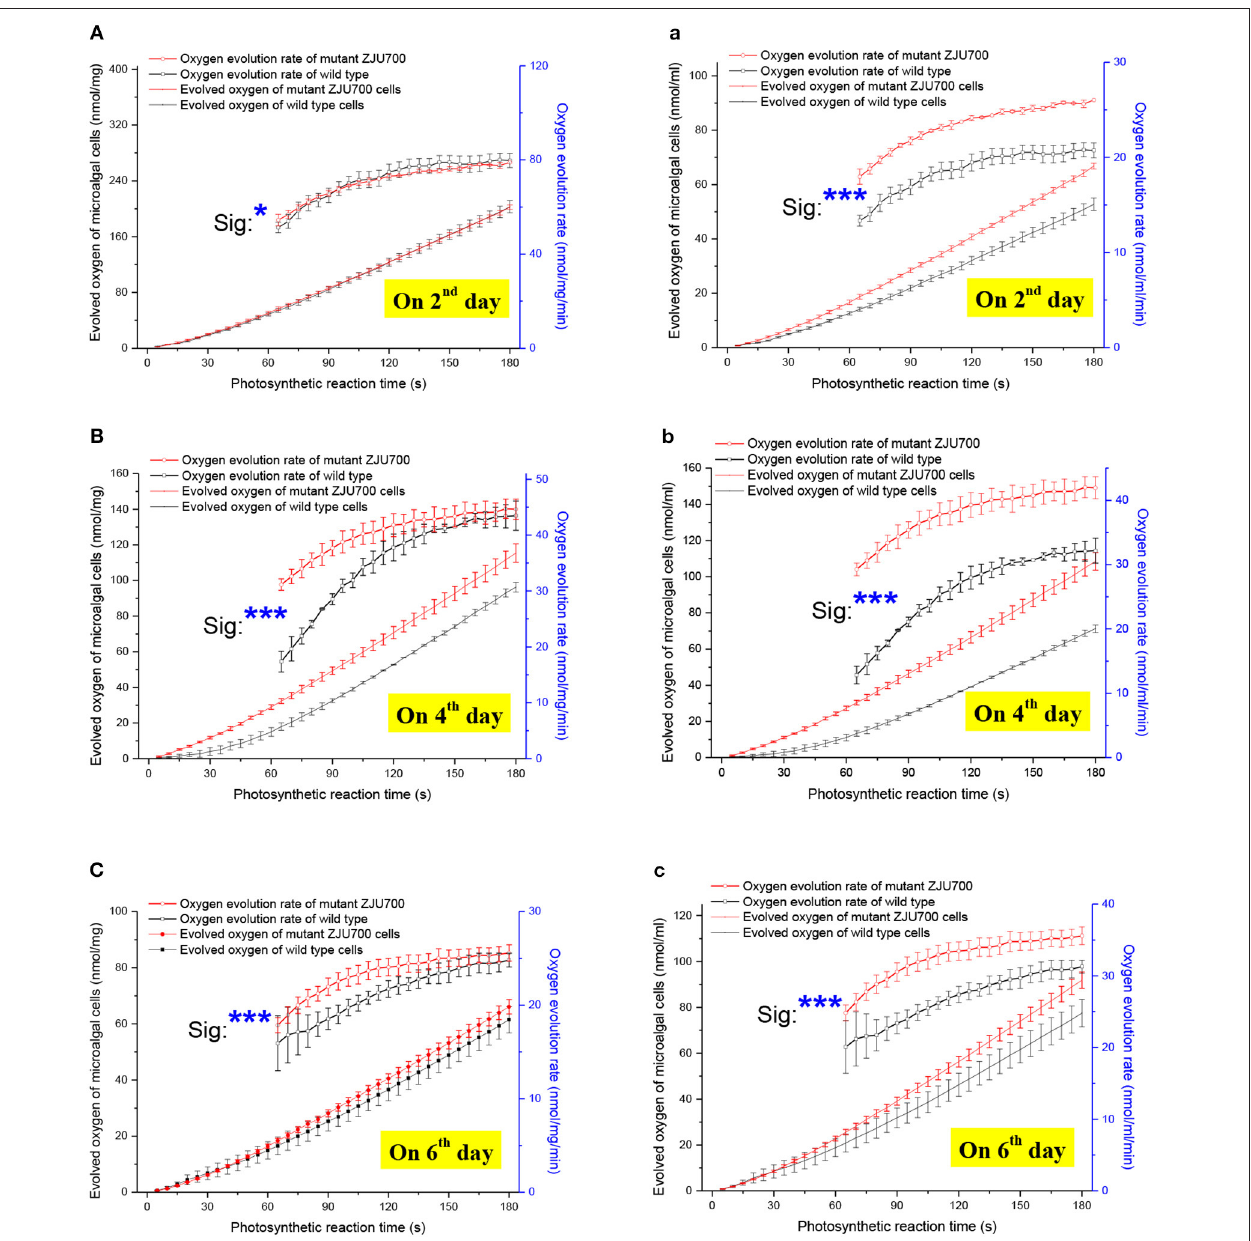
FIGURE 3 | Oxygen evolution rate of microalgal cells of Nannochloropsis mutant ZJU700. Normalized to dried biomass weight: (A) Day 2, (B) Day 4, (C) Day 6. Normalized to culture volume: (a) Day 2, (b) Day 4, (c) Day